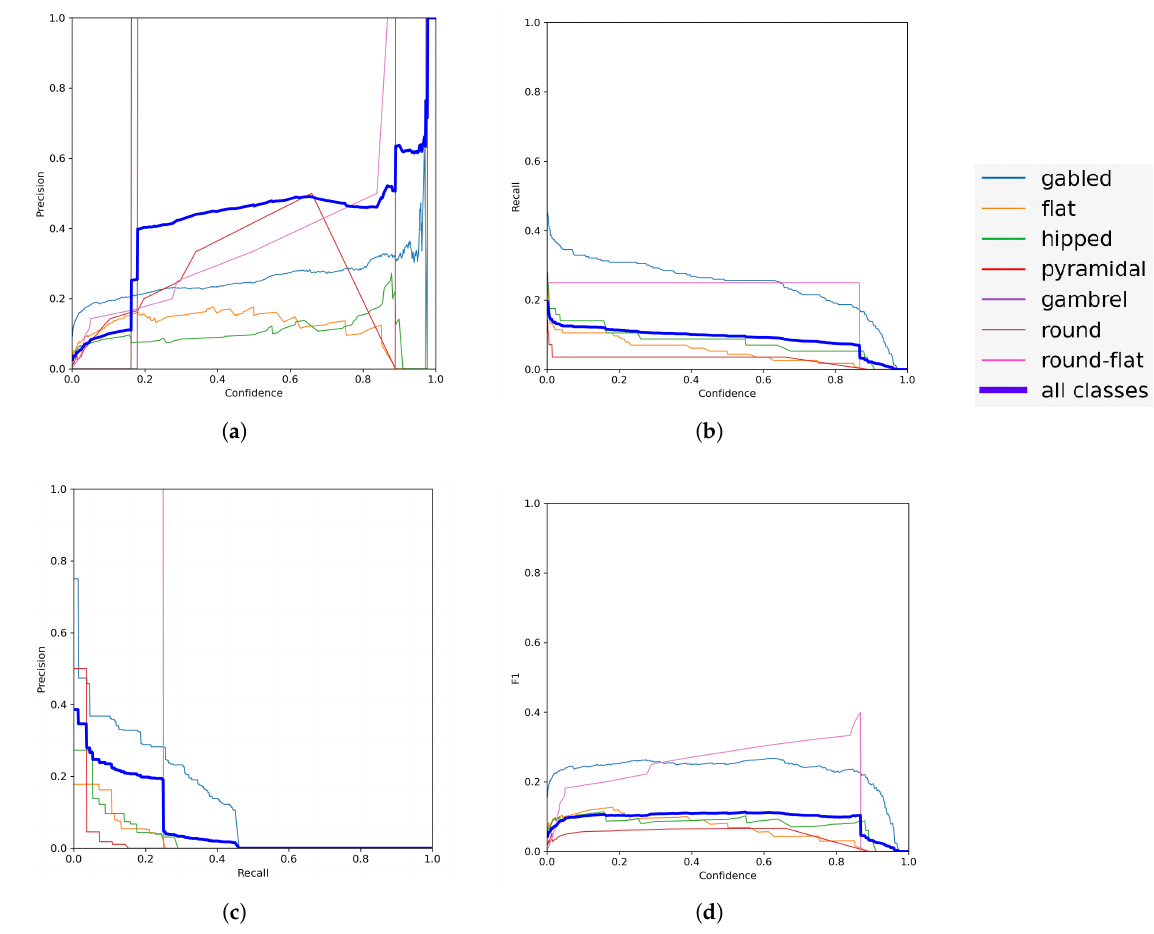
Figure 7. Metrics: ( a ) precision, ( b ) recall, ( c ) mAP, and ( d )